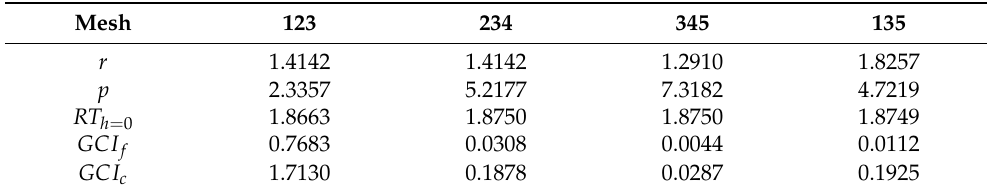
Table 2. Grid convergence index (GCI).